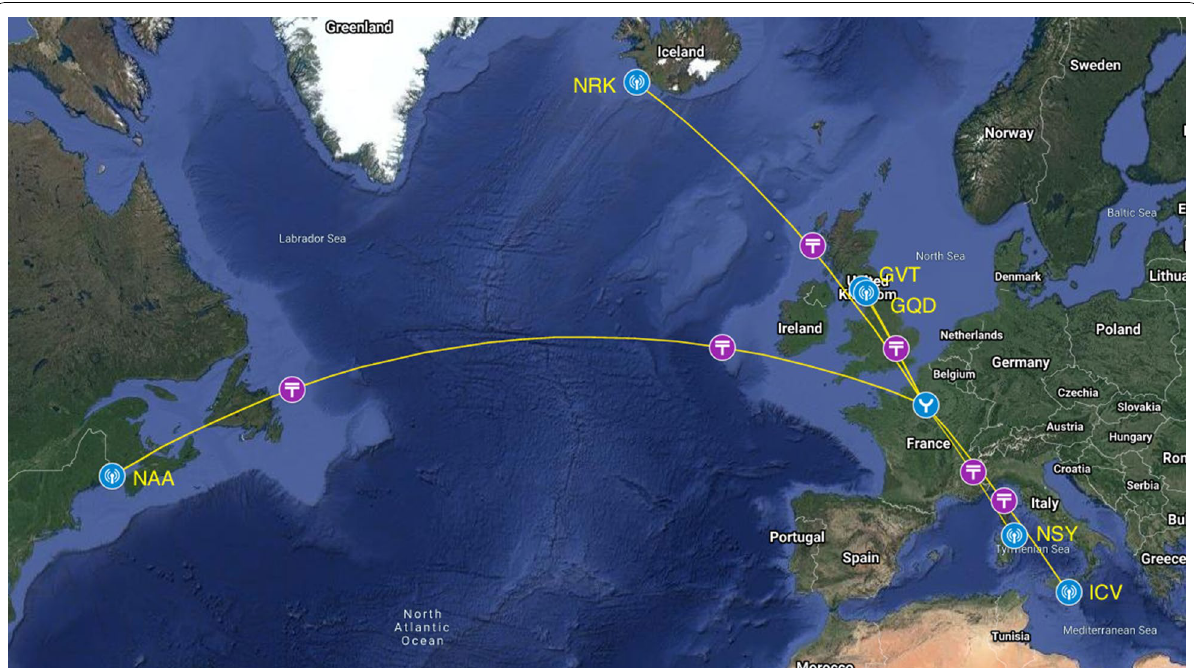
Fig. 1 Great Circle Path (GCP) between the VLF/LF stations used in the analysis and Meudon (France). Violet points indicate the sub-reflection area on the ionosphere. Blue circles indicate the transmitter location. Note that NRK, GVT (Skelton, Cumbria), GQD (Anthorn), ICV and NSY are almost aligned. The antenna is orientated to optimize their